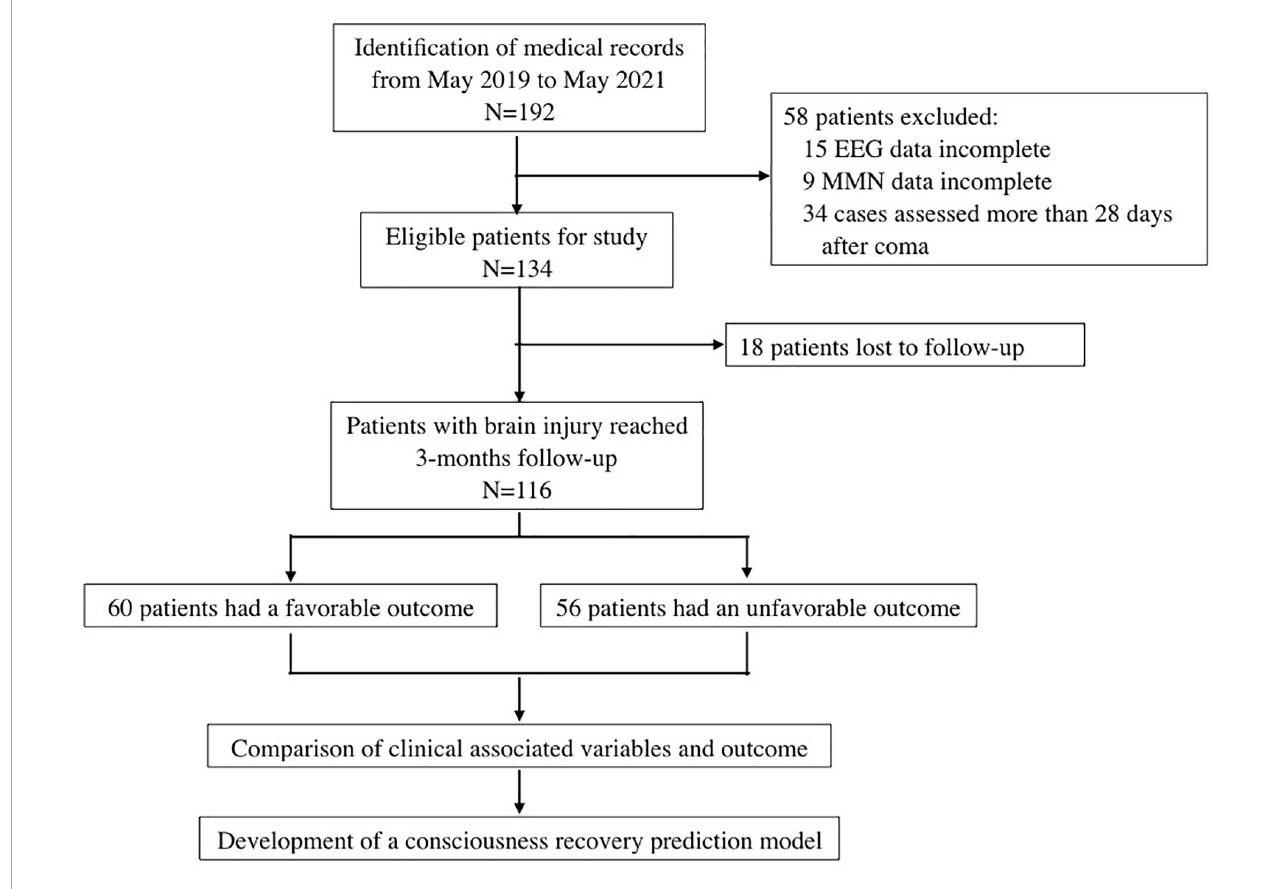
FIGURE1 Flow chart of this study.